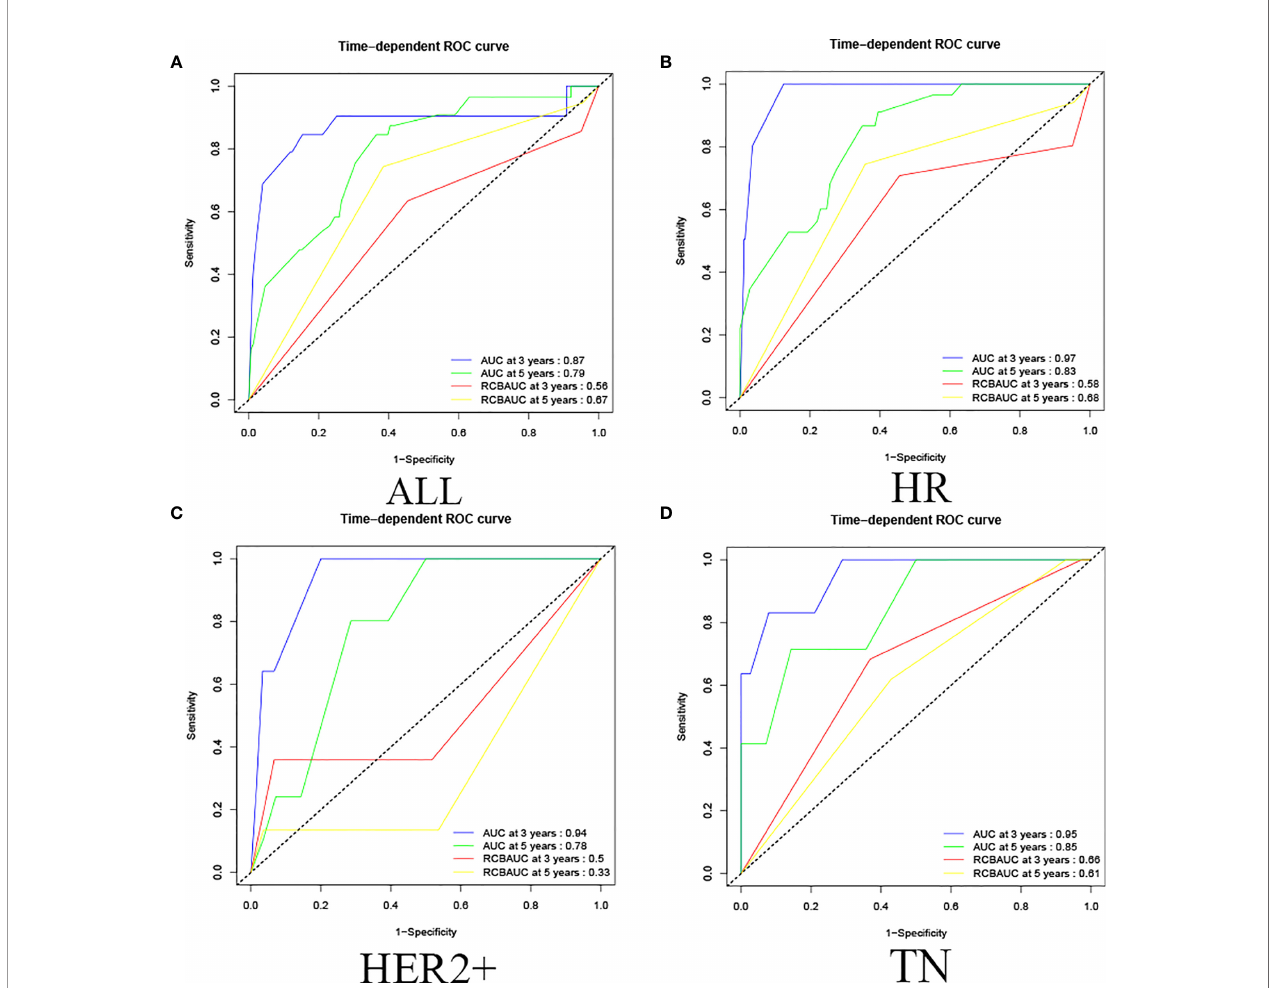
FIGURE 5 | Validation set ROC curve. (A) Among all cases in the validation set, the prediction model of 3-year survival AUC value was 0.87 and the 5-year survival AUC value was 0.79, and the RCB classi fi cation of 3-year survival and 5-year survival were 0.56 and 0.67. (B) In HR, the AUC values of 3-year and 5-year survival rate calculated by the predictive model were 0.97 and 0.83, the RCB classi fi cation of 3-year survival and 5-year survival were 0.58 and 0.68; (C) in HER2+, the AUC values of 3-year and 5-year survival rate calculated by predictive model were 0.94 and 0.78, the RCB classi fi cation were 0.50 and 0.33; (D) in TN, the AUC values of 3-year and 5-year survival rate calculated by the predictive model were 0.95 and 0.85, and the RCB classi fi cation were 0.66 and